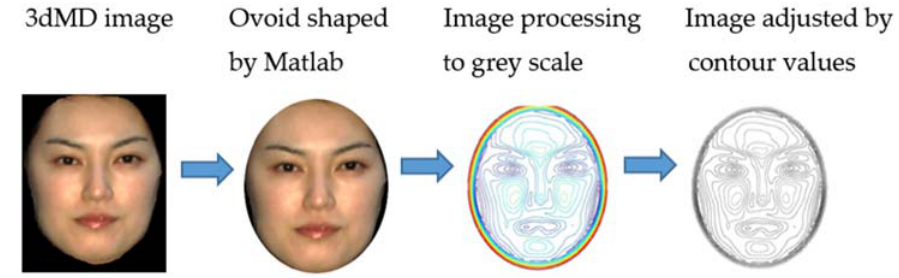
Figure 1. Extraction of 3D contour lines from 3dMD images.